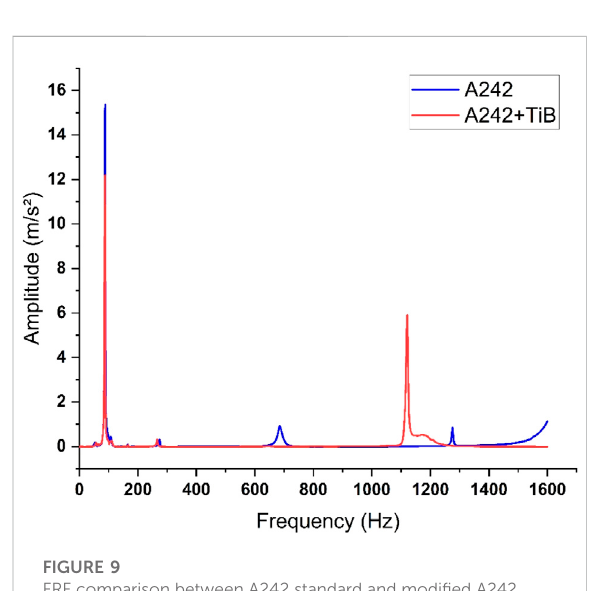
FRF comparison between A242 standard and modi fi ed A242 + TiB